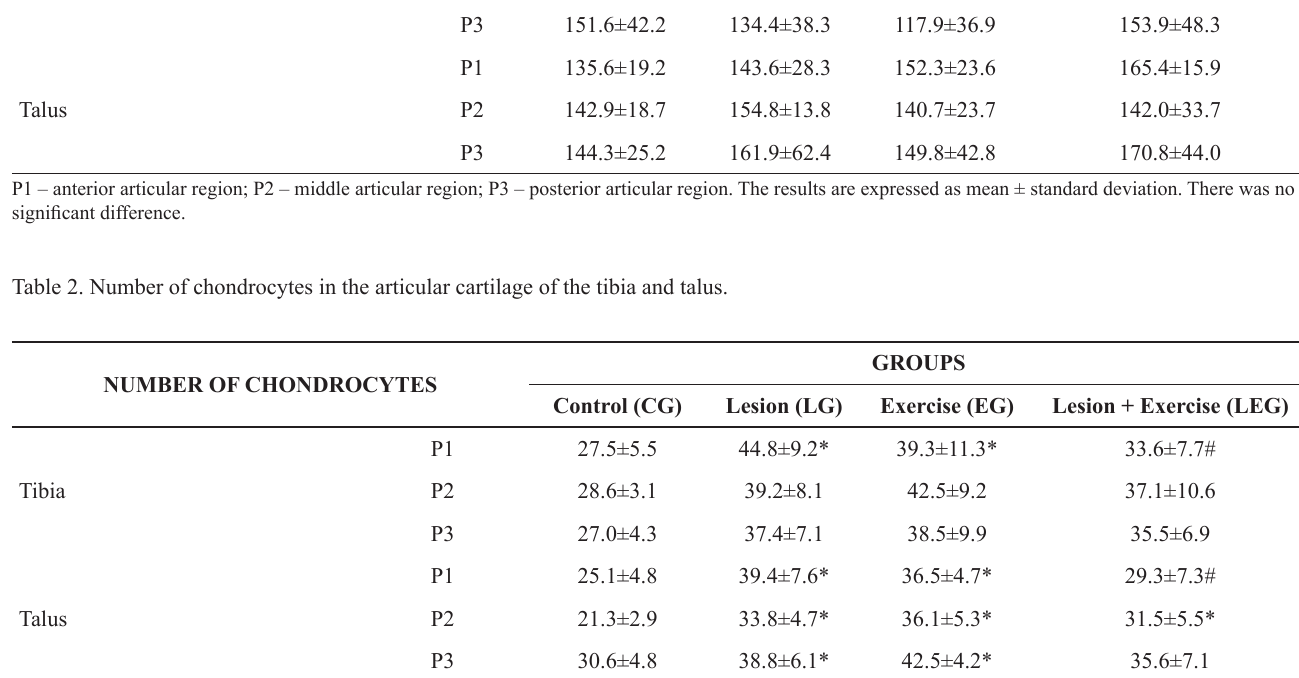
THICKNESS OF CARTILAGE